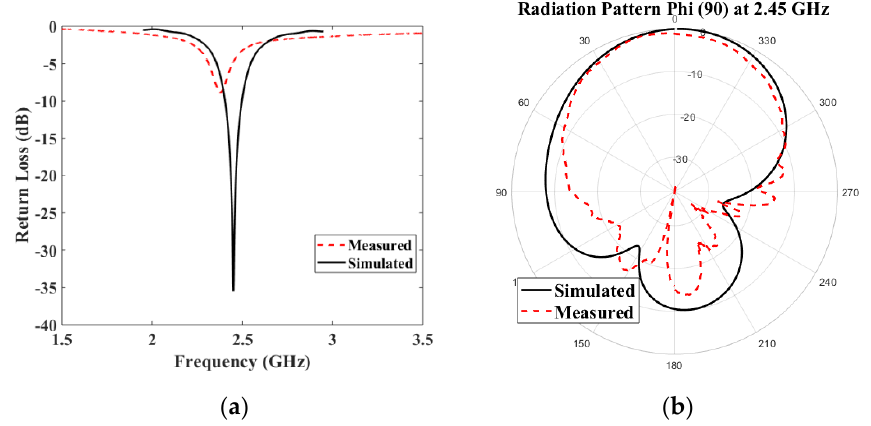
Figure 8. Antenna on cotton fabric at 2.45 GHz; ( a ) reflection coefficient S 11 computed vs measured and ( b ) radiation pattern Phi (ϕ) 90 computed vs measured.